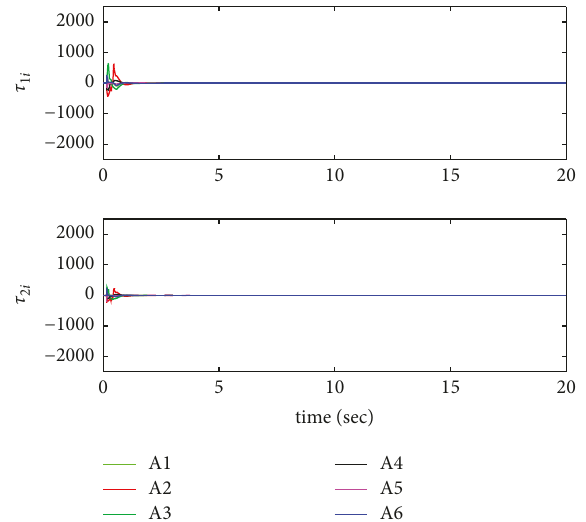
and q and the fault-free case (AFSFC). 1 i 2 i